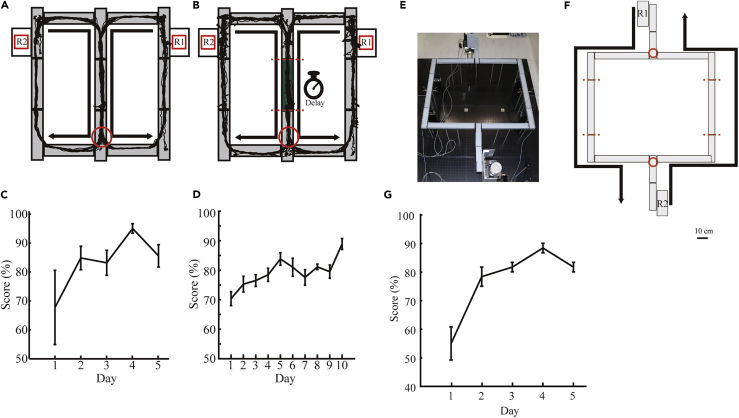
Rats and Mice Can Learn to Navigate the Configured Mazes(A) Schematic of the figure-8-shaped maze created using the rat version of the reconfigurable maze. Example animal trajectories are superimposed on top of the maze. The red circle indicates a branchpoint where the rat must decide which direction to turn.(B) Same as in (A) but with a treadmill (green). Red dashed lines indicate the gap locations where movable walls are placed to force the rats to run on the treadmill for a delay period.(C) Spatial alternation task performance improved with experience (performance versus testing day: F1, 4 = 795.9, p < 10−5).(D) Performance of the delayed version of the spatial alternation task of rats improved with experience (performance versus testing day: F1,2 = 531.8, p = 0.0019). All were from one-way repeated-measures ANOVA. Error bars indicate SEM.(E) Top view of the configured double T-maze using the mouse version of the reconfigurable maze.(F) Schematics of the double T-maze. Example mouse trajectories are superimposed on the maze. Arrow marks the running directions from the food dispensers (R1/R2). The red circles indicate branch points where the mice must decide which direction to turn. Red dotted lines indicate the locations where the movable walls are placed to prevent a reverse run.(G) Spatial alternation task performance of mice improved with experience (performance versus testing day: F1,2 = 7320, p = 0.000136).One-way repeated-measures ANOVA was used. Error bars indicate SEM.